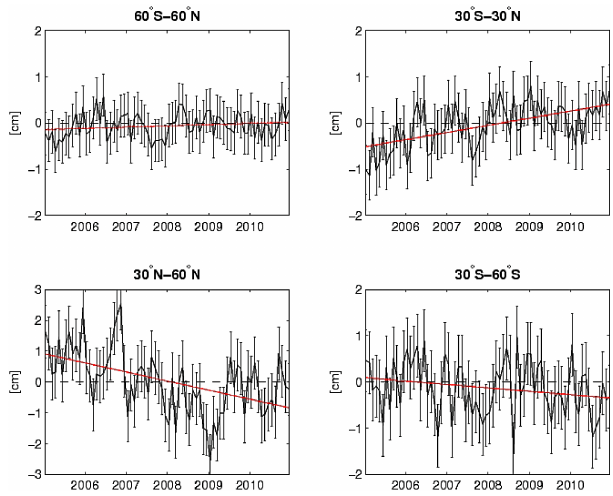
Figure 2. Residual of the sea level budget at different latitude bands using Argo steric sea level (Fig. 3a, red), AVISO delayed- mode gridded fields and GRACE data. Residual trends amount to 0.3 ± 0.6mmyears − 1 for the global ocean, 1.6 ± 0.7mmyears − 1 for the Tropical Ocean, − 3 ± 0.9 for the Northern Ocean, and − 0.7 ± 0.7 for the Southern Ocean. See text for more details on data, method and error